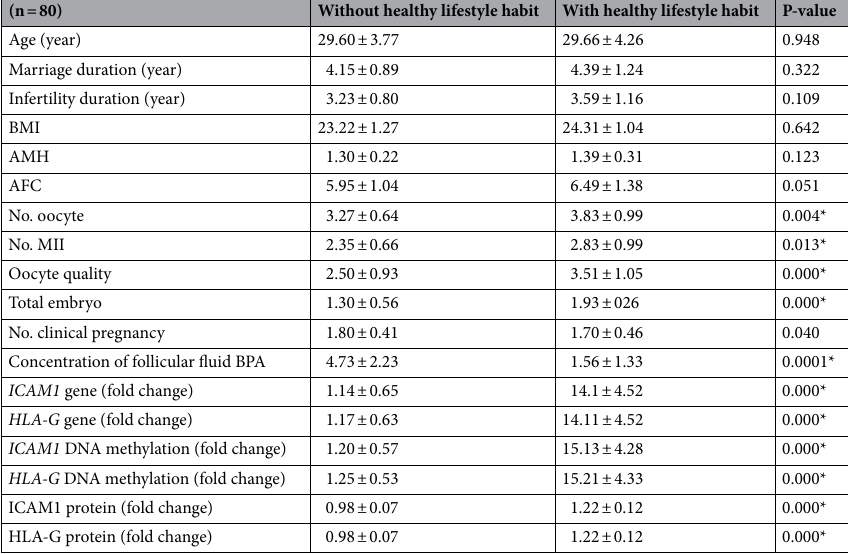
Table 2. Clinical parameters for without healthy lifestyle habit and with healthy lifestyle habit of POR patients. Continuous variables are presented as mean ± SD. AFC: antral follicular count AMH: anti Müllerian hormone, MII: Retrieved oocytes were classified into metaphase II, BPA concentration value is reported as ng/mL. *P < 0.05 was considered